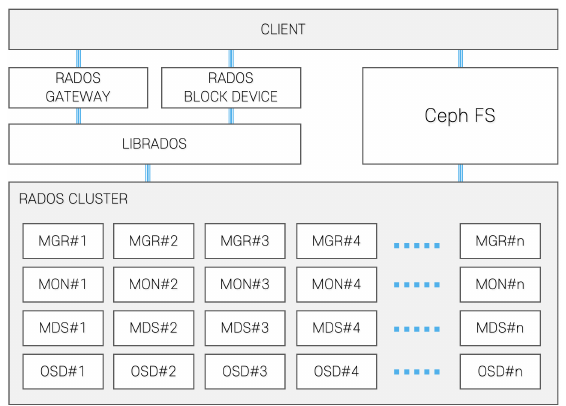
Figure 1. Structure of Ceph.